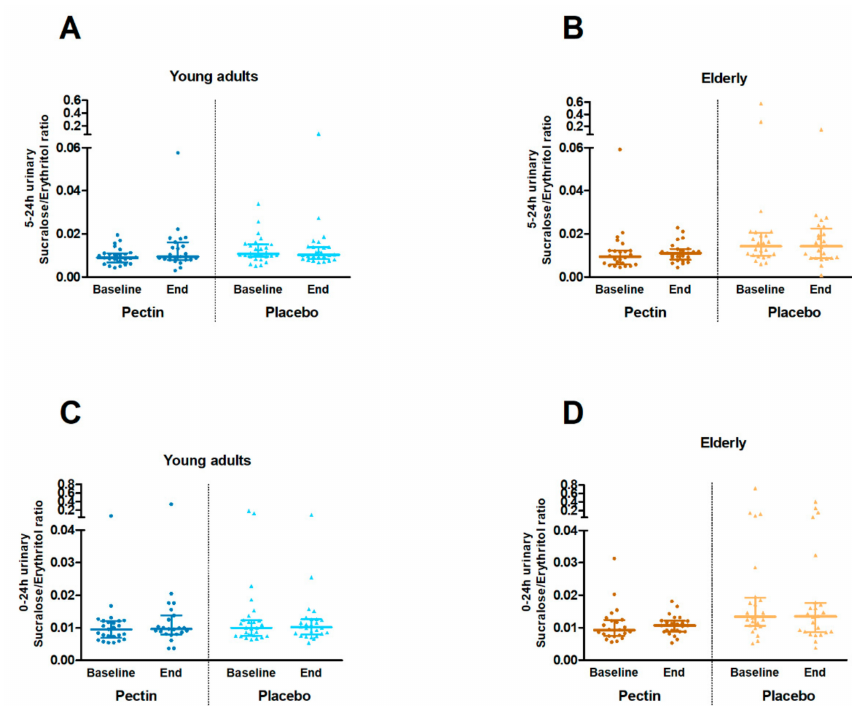
Figure 4. Colonic and whole gut permeability in vivo at baseline and after four weeks of placebo (triangles) and pectin (circles) intervention in young adults and elderly. ( A ) 5–24 h urinary sucralose / erythritol ratio in young adults. ( B ) 5–24 h urinary sucralose / erythritol ratio in elderly. ( C ) 0–24 h urinary sucralose / erythritol ratio in young adults. ( D ) 0–24 h urinary sucralose / erythritol ratio in elderly. Values are presented in scatter plots with median line and IQR (25–75th interquartile range). Sample size di ff erences between baseline and end are due to drop-outs. Within age groups, urinary sugar ratios were compared between intervention groups with unstructured linear mixed models and correction for baseline